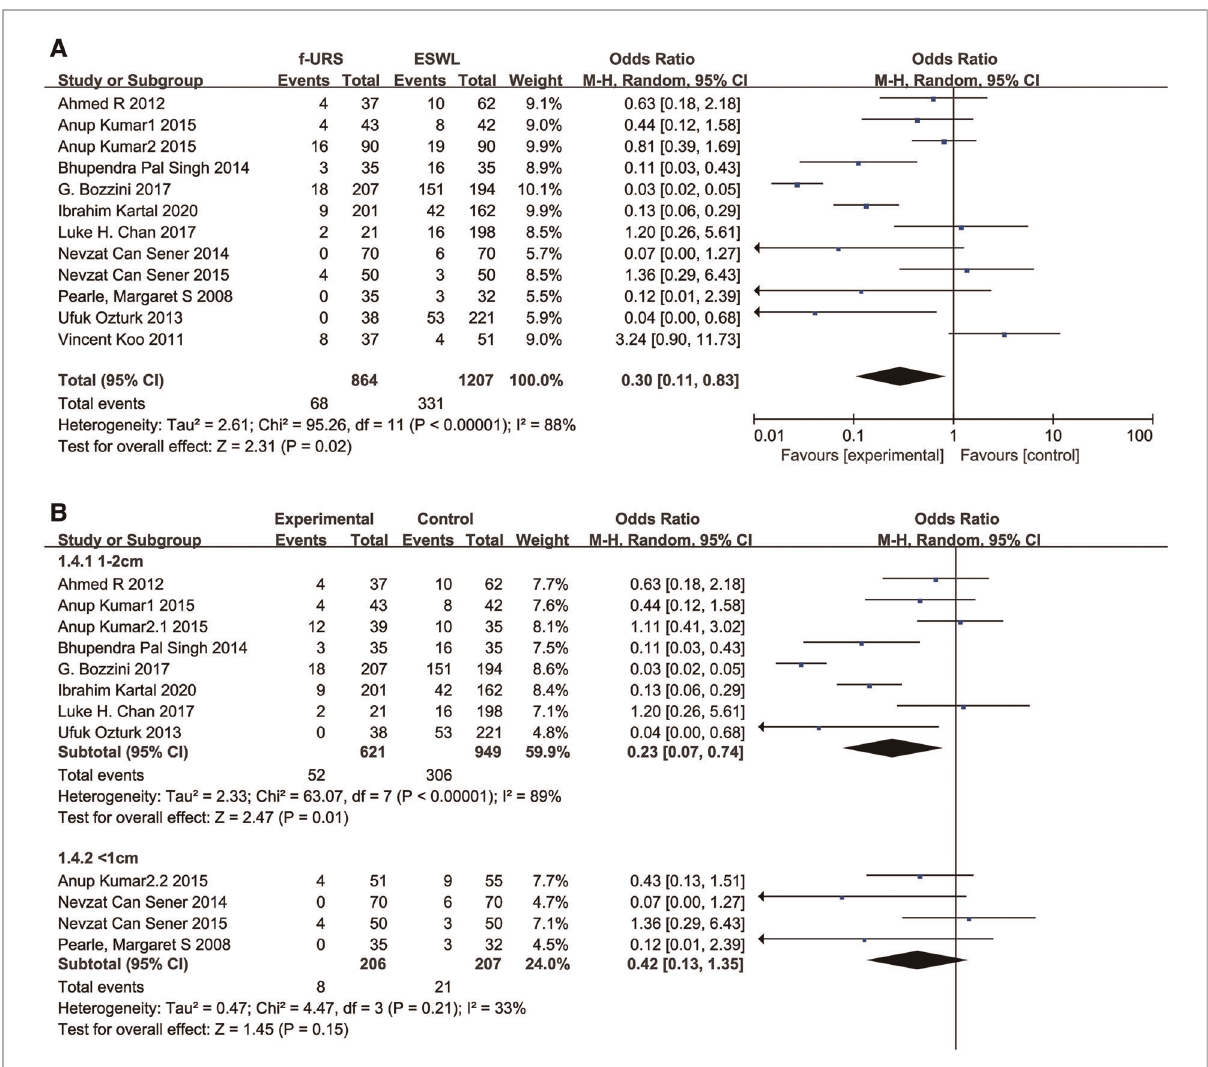
FIGURE 7 Forest plot and meta-analysis of auxiliary procedure rate for ( A ) all studies and ( B ) subgroups of stone length 1 – 2 cm and <1 cm for f-URS and